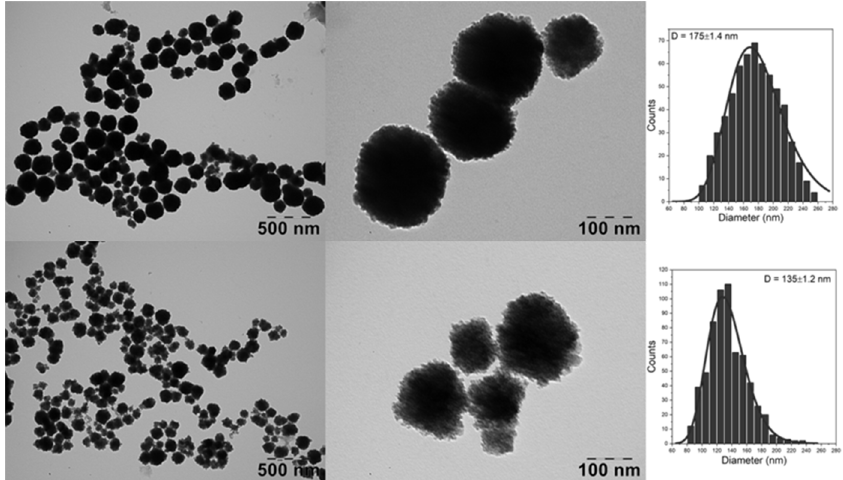
Figure 1. Large scale and high resolution TEM images together with the corresponding diameter distribution histograms fitted with a log-normal distribution (purple lines) of DHBH@MNC (upper panels) and PDHBH@MNC (lower